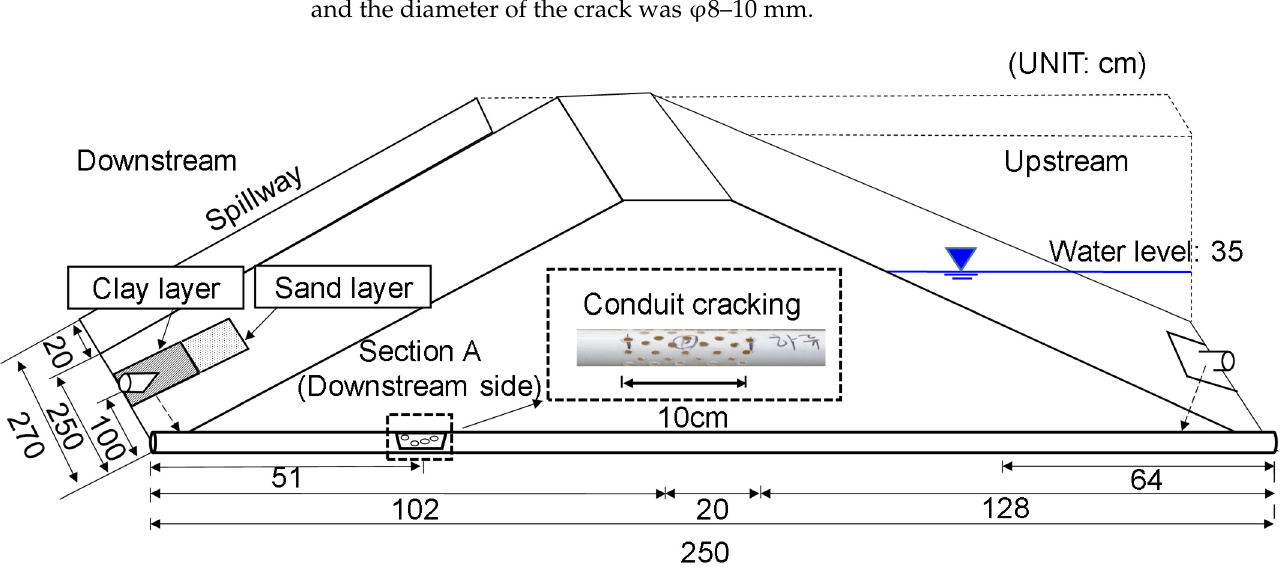
Table 1. Physical and mechanical properties of samples used in the model.